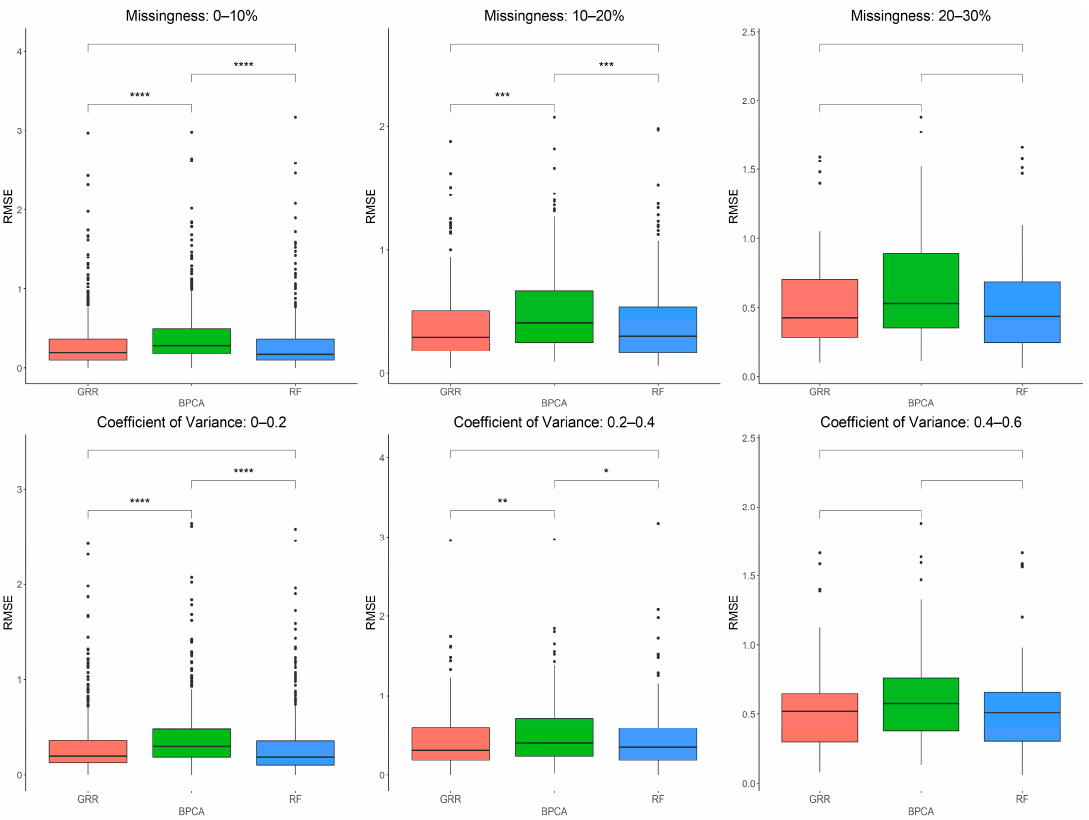
Figure 6. Evaluations of imputation accuracy in the complete baboon liver. Accuracy is evaluated for a mixture of missingness types (MCAR–MAR–MNAR). Methods are listed across the x-axis, and RMSE is shown on the y-axis. The top row compares accuracy across a range of missingness types. The bottom row compares accuracy across a range of coefficients of variance. The center line represents the median. The lower and upper box limits represent the 25% and 75% quantiles, respectively. The whiskers extend to the largest observation within the box limit ± 1.5 × interquartile range. Black dots represent single iterations of evaluating RMSE that are outliers. The p-values are based on pairwise testing with the Wilcoxon Rank Sum test (* corresponds to p ≤ 0.05; ** corresponds to p ≤ 0.01; *** corresponds to p ≤ 0.001; **** corresponds to p ≤ 0.0001).